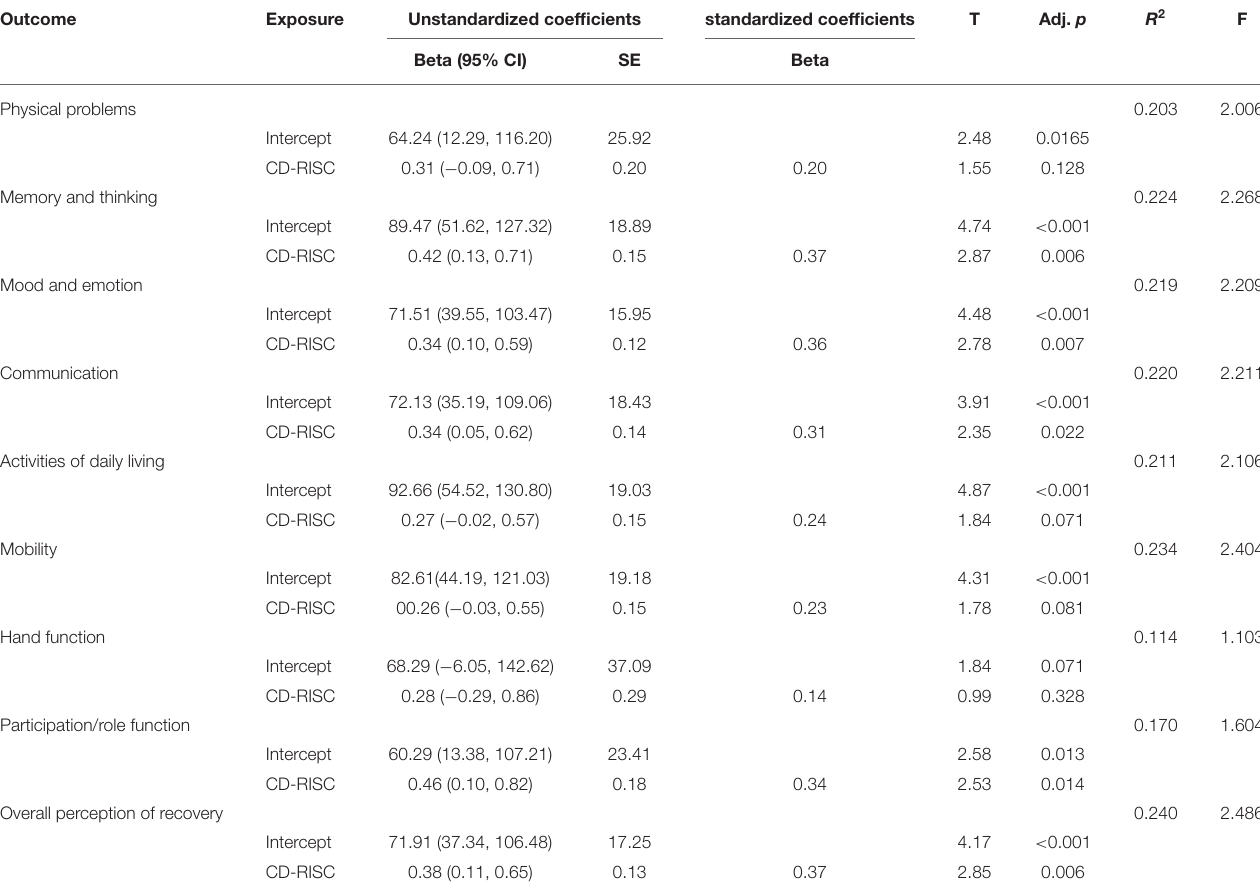
TABLE 6 | Main effect of resilience (CD-RISC) on Stroke Impact Scale